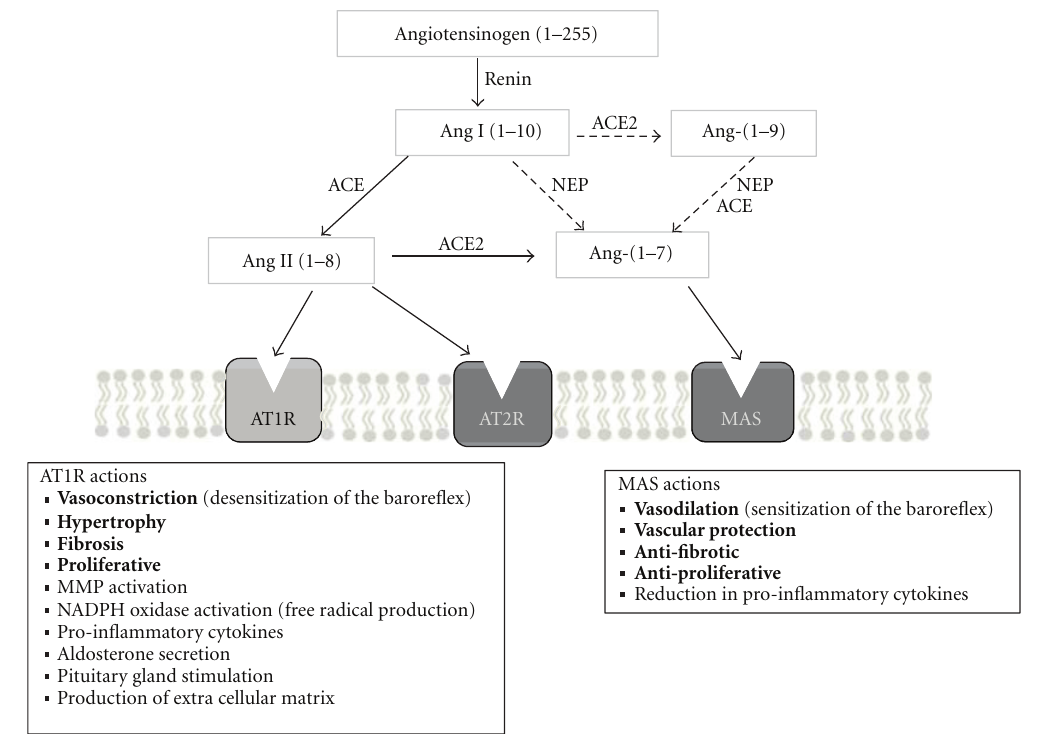
Figure 1: Schematic representation of the renin-angiotensin system (RAS). ACE: angiotensin-converting enzyme; ACE2: angiotensin- converting enzyme 2; NEP: neprilysin; AT1R: Ang II type 1 receptor. Angiotensinogen is cleaved by renin in the circulation to